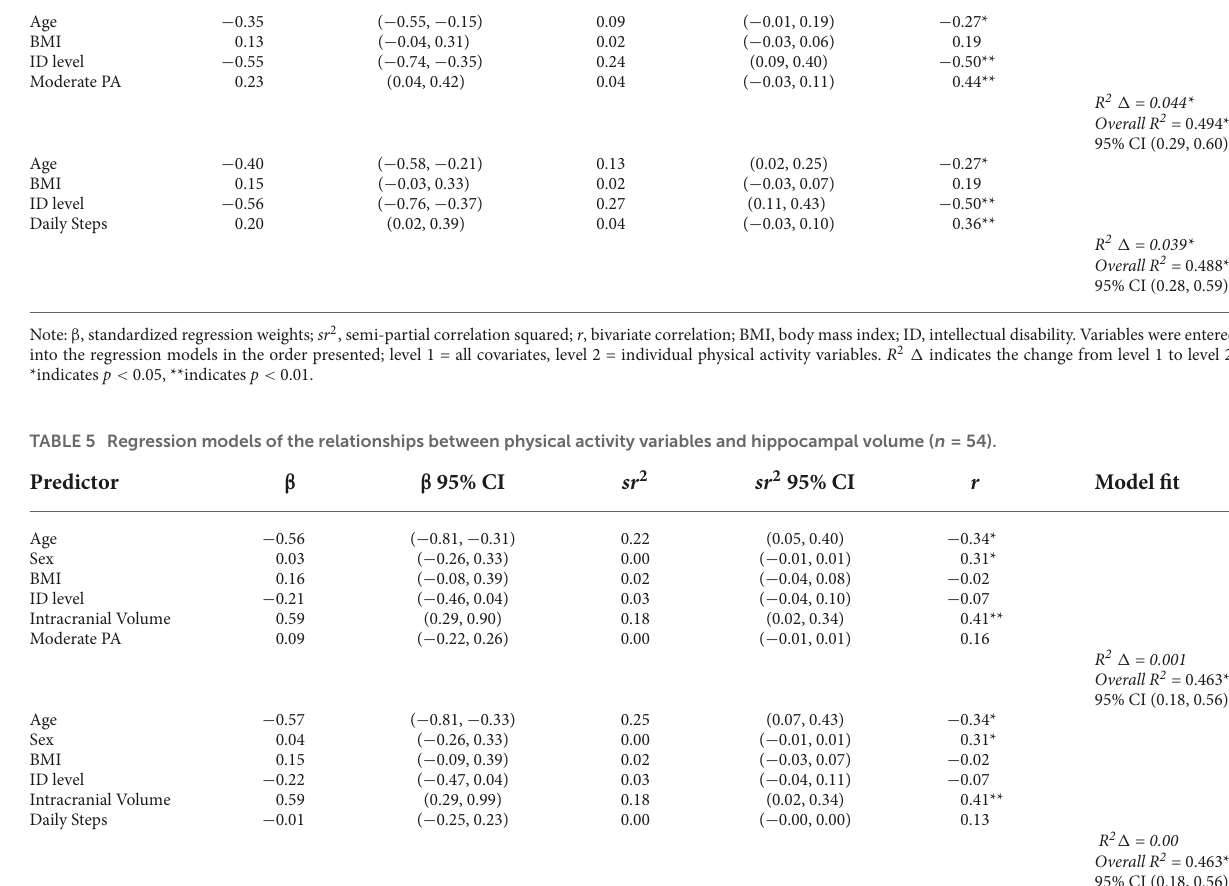
TABLE 4 Regression models of the relationships between physical activity variables and memory composite score ( N = 71). Predictor